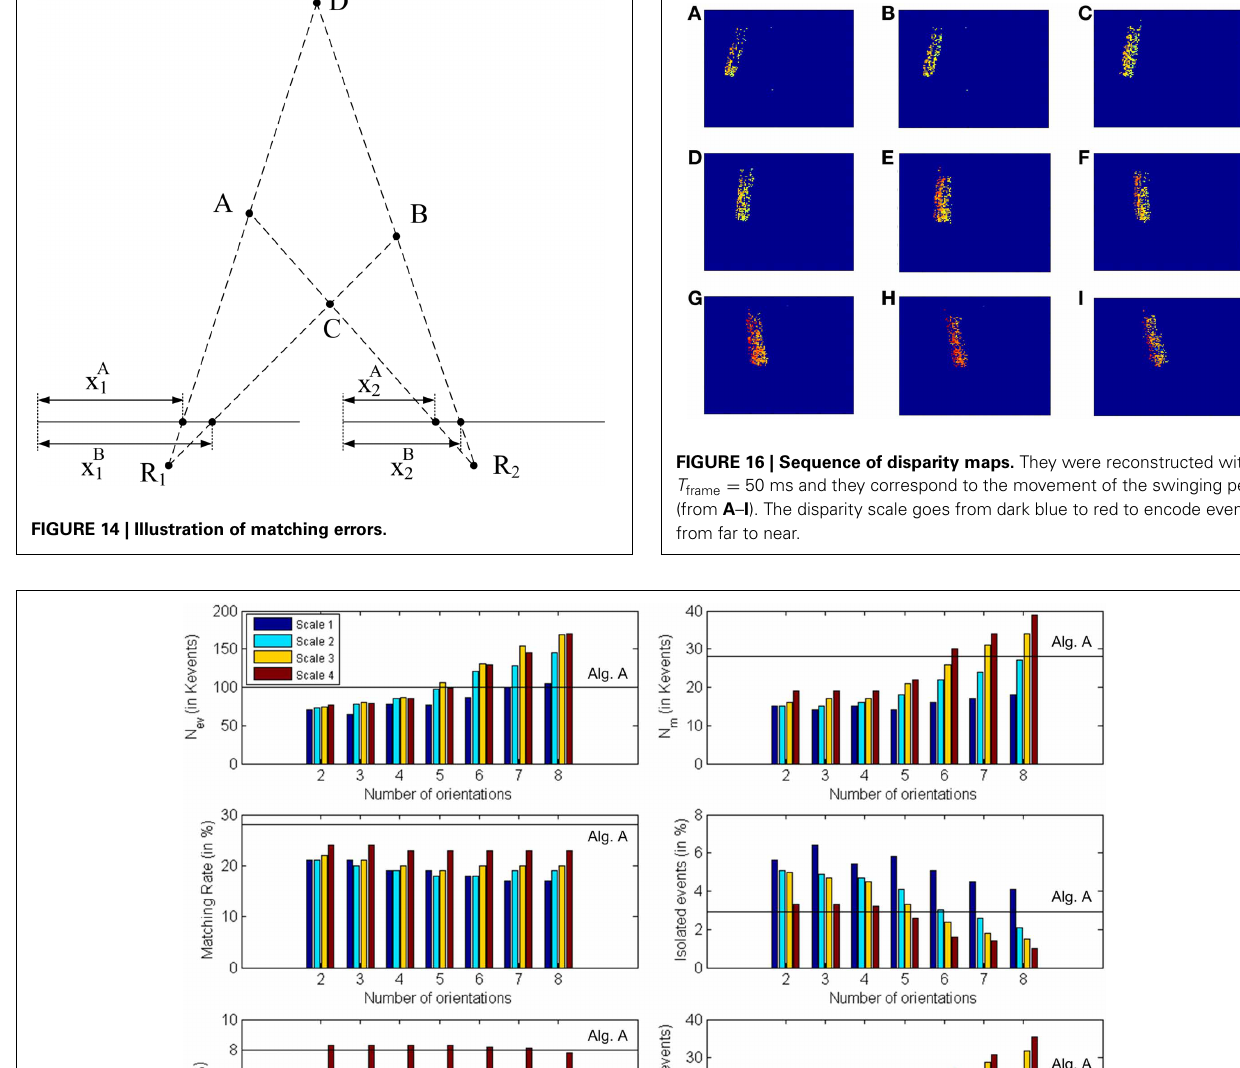
Frontiers in Neuroscience | Neuromorphic